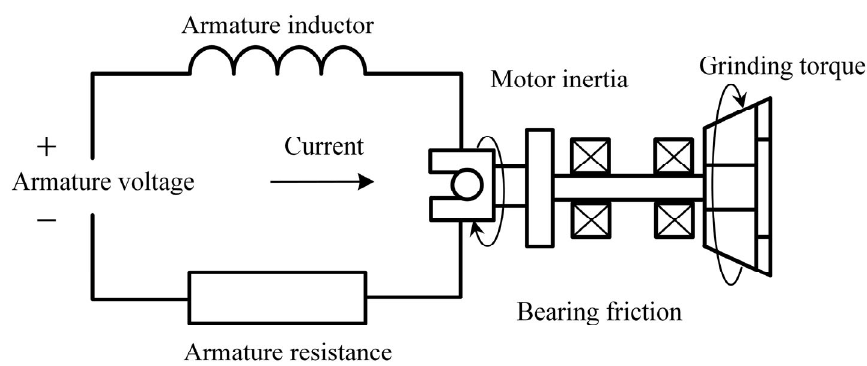
Figure 4. CNC tool grinding machine spindle drive chain.